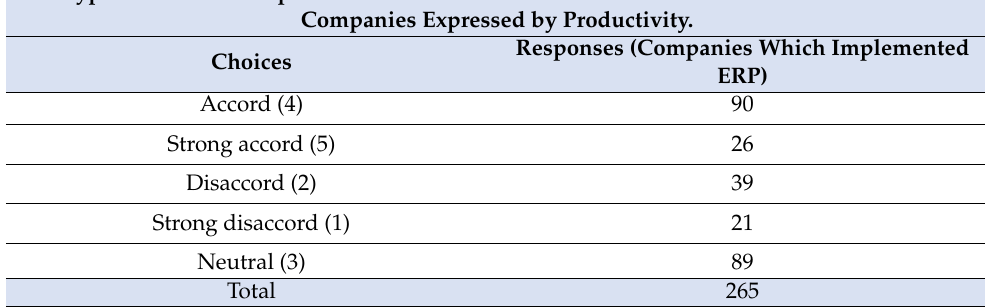
Table 6. Results of questionnaire responses for Hypothesis 2-respondents who implemented